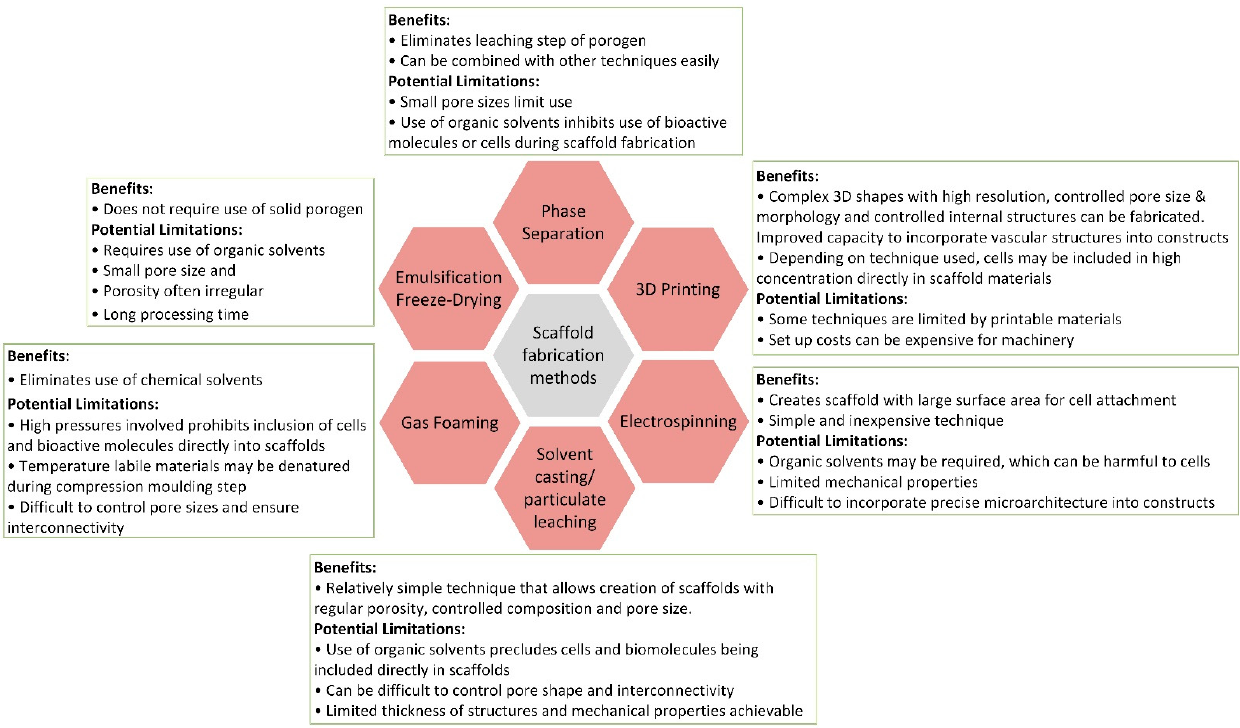
Figure 6. Benefits and potential limitations of different scaffold fabrication methods. Realized based on [59].